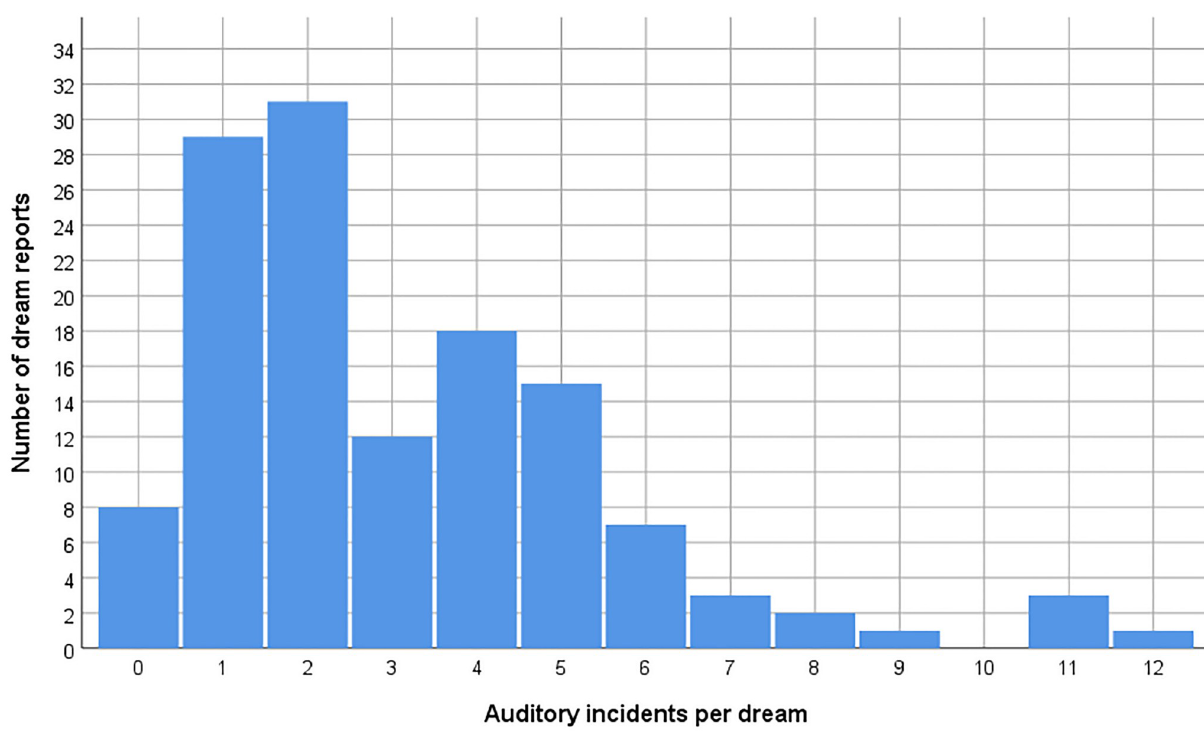
Fig 1. Number of auditory incidents in 130